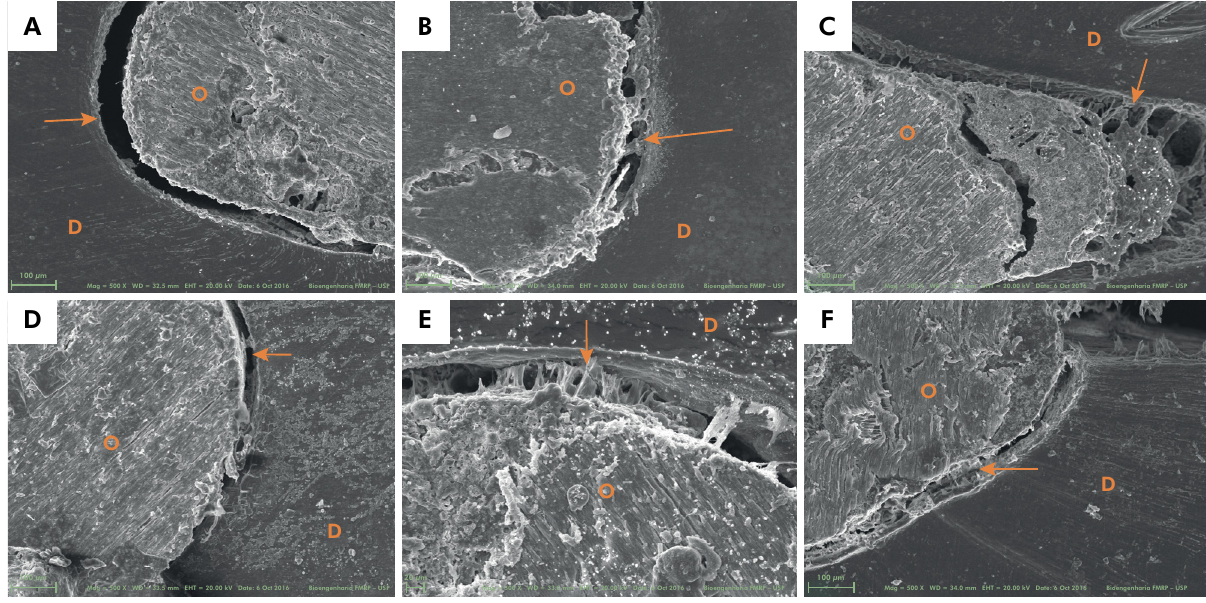
Figure 2. SEM micrographs obtained after the surface deproteinization protocol, showing the sealer/dentin interface in non-irradiated and irradiated teeth, irrigated with (A) NaOCl, (B) EDTA, and (C) chitosan, and filled with the lateral condensation technique using AH Plus sealer (1000x). D: dentin; O: